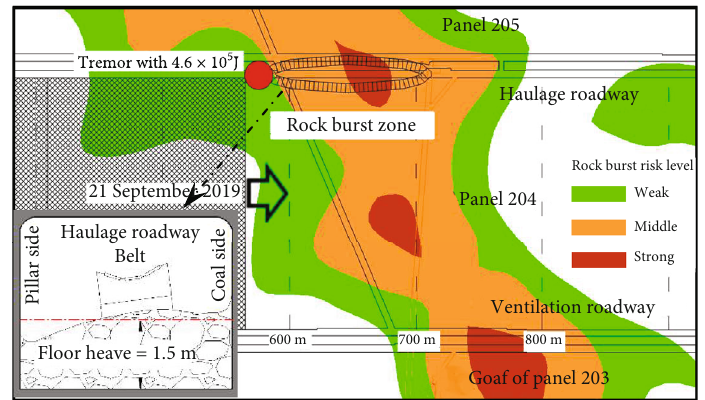
Figure 10: Rock burst zones on 15 September 2019 and rock burst occurred on 21 September 2019.